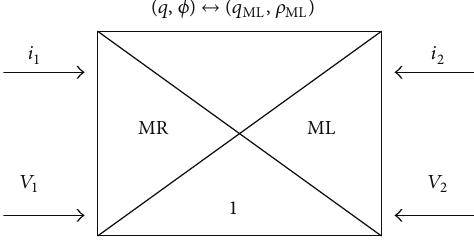
Figure 2: Characterization of MR-ML